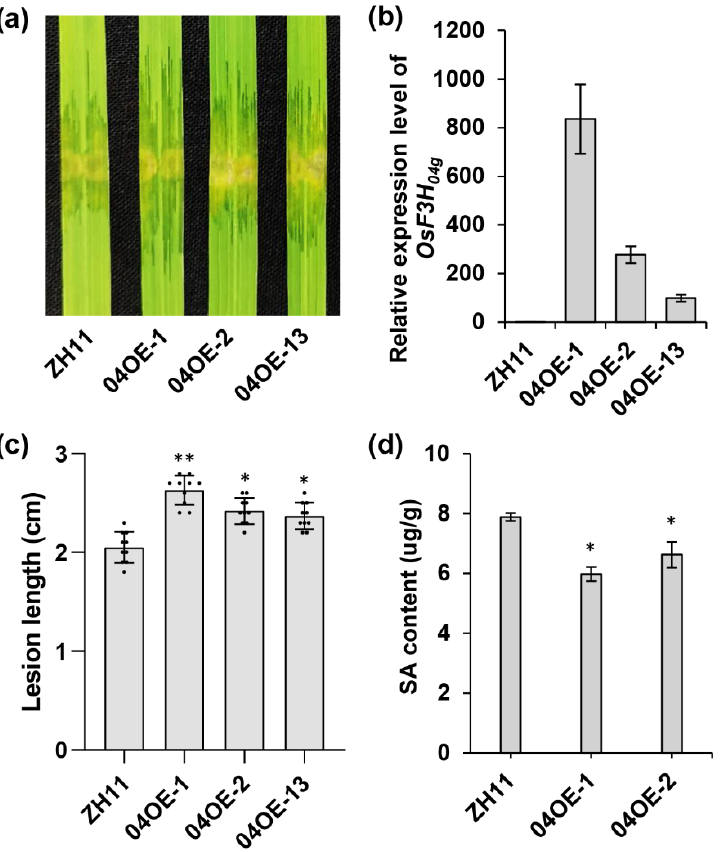
Figure 2. Overexpression of OsF3H 04g increases rice susceptibility to Xoc strain RS105. ( a ) Photo- graph of lesion expansion at 14 dpi with RS105 in ZH11 and OsF3H 04g OE lines. ( b ) Quantification of OsF3H 04g expression in the ZH11 and OsF3H 04g overexpression (OE) lines (04OE-1, 04OE-2 and 04OE-13). OsACTIN was used as an internal control. Data represent the means ± SD, n = 3. ( c ) Dia- gram of lesion lengths in ZH11 and OsF3H 04g OE lines at 14 dpi with RS105. Data represent the means ± SD, n = 10. Asterisks represent significant differences between ZH11 and OsF3H 04g OE lines (* p ≤ 0.05, ** p ≤ 0.01, Student’s t test). ( d ) Salicylic acid (SA) content in ZH11 and OsF3H 04g OE lines (04OE-1 and 04OE-2). Data represent the means ± SD, n = 3. Asterisks represent significant differ- ences between ZH11 and OsF3H 04g OE lines (* p ≤ 0.05, Student’s t test).